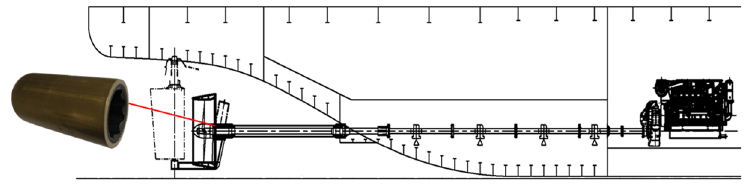
Figure 1. Marine propulsion shafting and stern bearing.